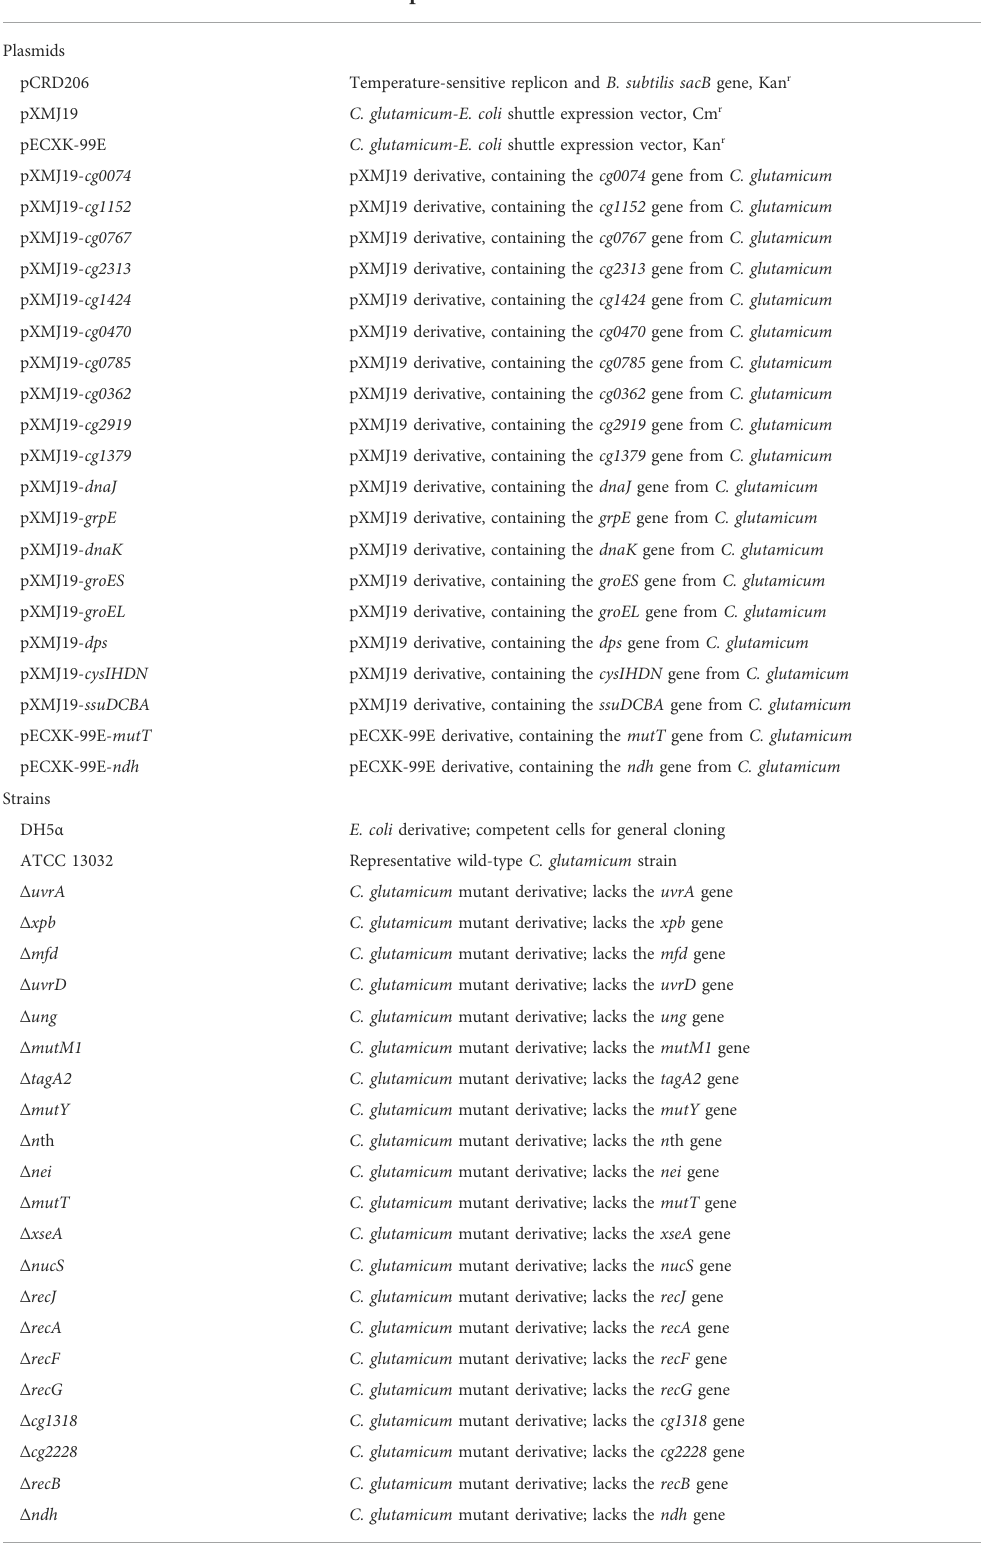
TABLE 1 Strains and plasmids used in this study. Plasmid or